Question: How would you classify this visualization?
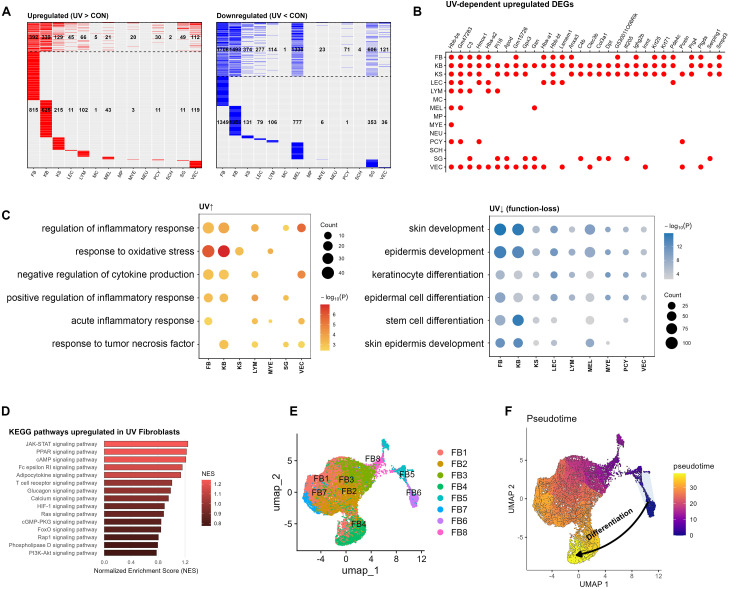
Answer: heatmap